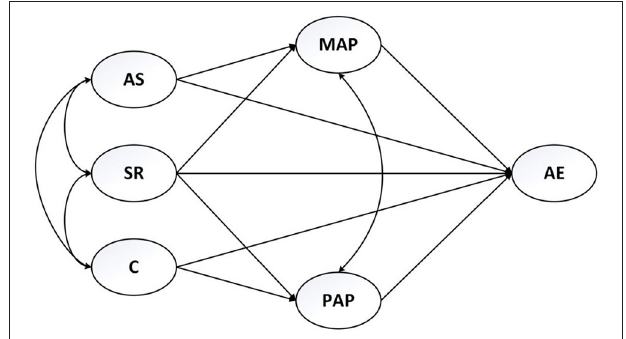
FIGURE 1 | The research model. AS, perceived autonomy support; SR, perceived social relatedness; C, perceived controlling; MAP, mastery-approach goals; PAP, performance-approach goals; AE, agentic